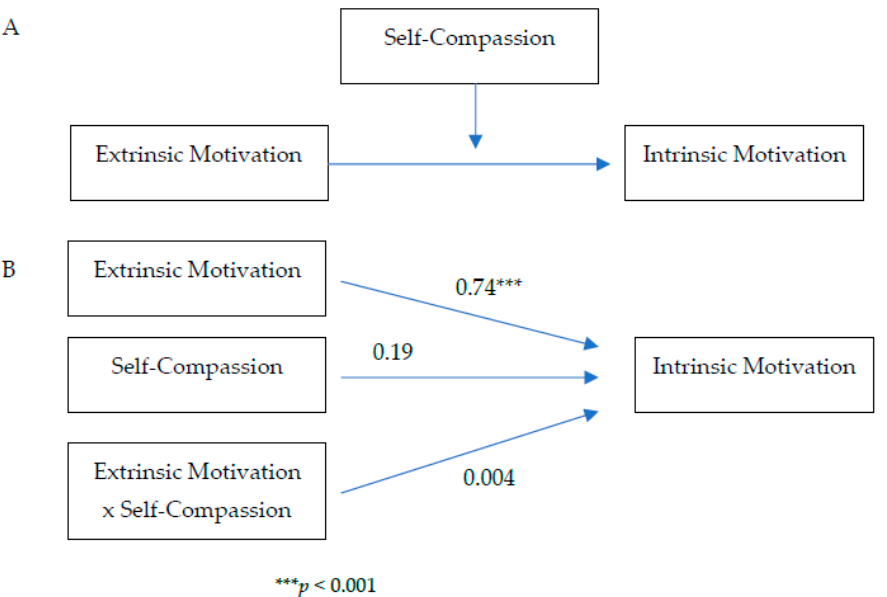
Healthcare 2022 , 10 , x FOR PEER REVIEW Figure 1. Moderation of self-compassion on the pathway from extrinsic motivation to intrinsic motivation: conceptual diagram ( Panel A ) and statistical diagram ( Panel B ).